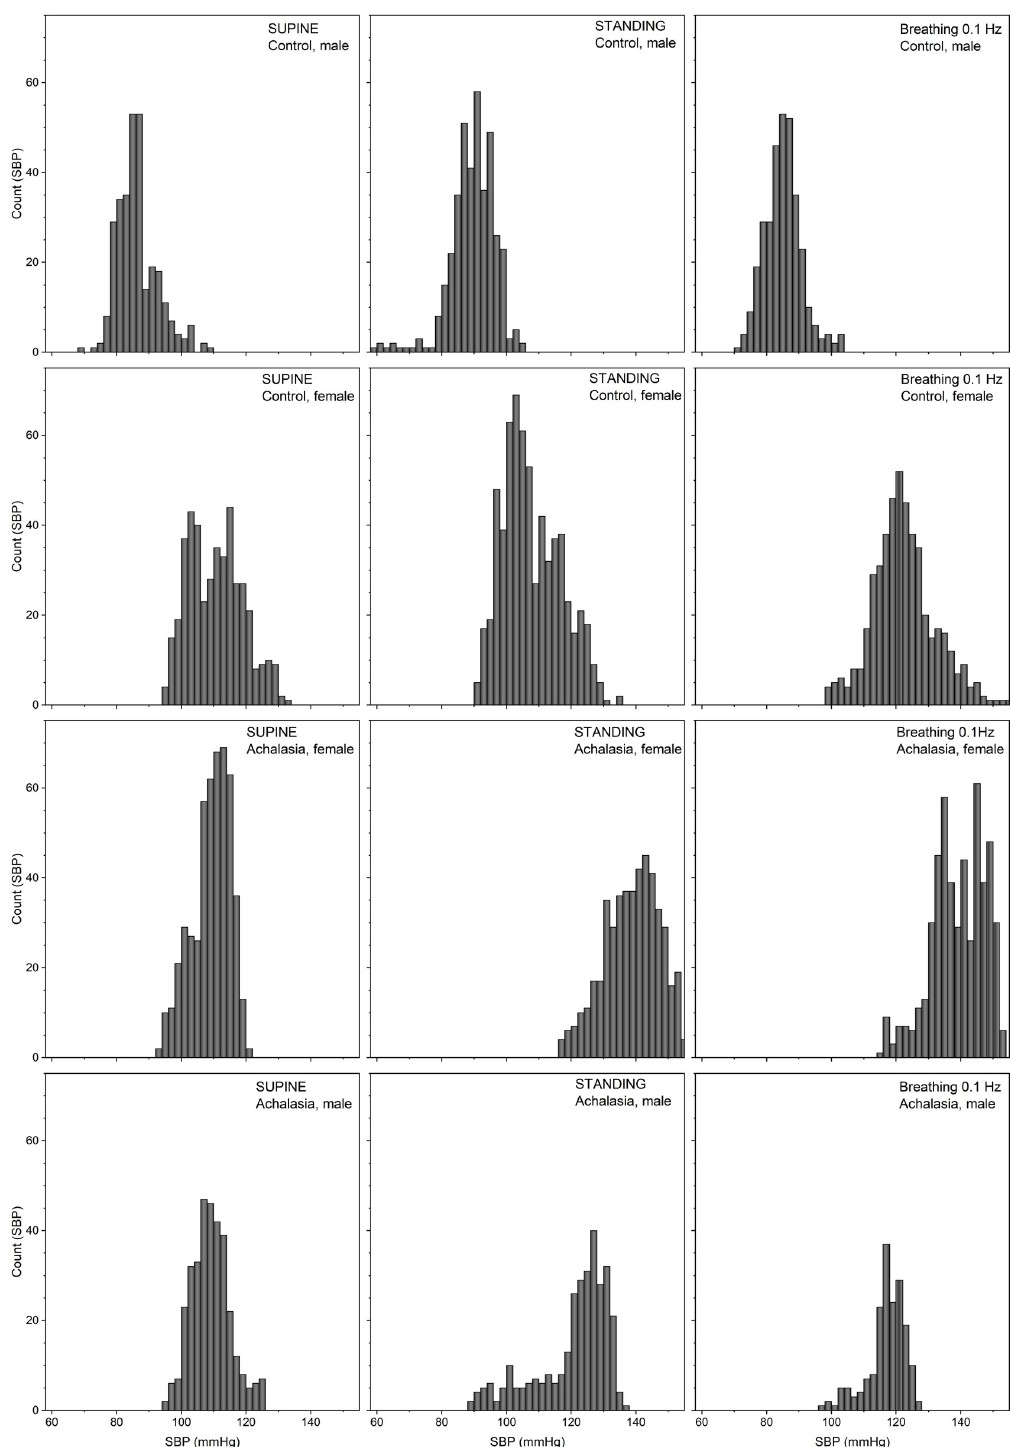
Fig 3. Histograms of SBP detrended time series for typical patients (30 years old). Male M30C01 and female F30C01 control (upper rows), female F30A01 achalasia patients (middle row) and male M30A01 achalasia patients (lower row) on supine position (left-hand column), standing up (middle column), and under controlled breathing at 0.1 Hz (right-hand column).